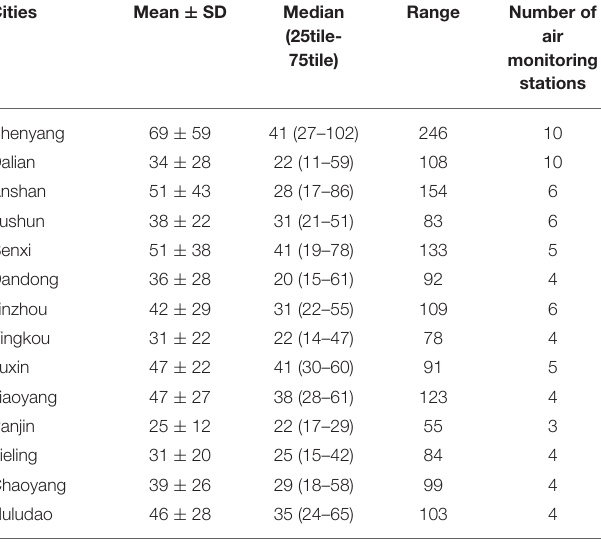
TABLE 1 | Characteristics of controls and cases in Liaoning Province, China, 2010–2015 [no. (%)]. Characteristic